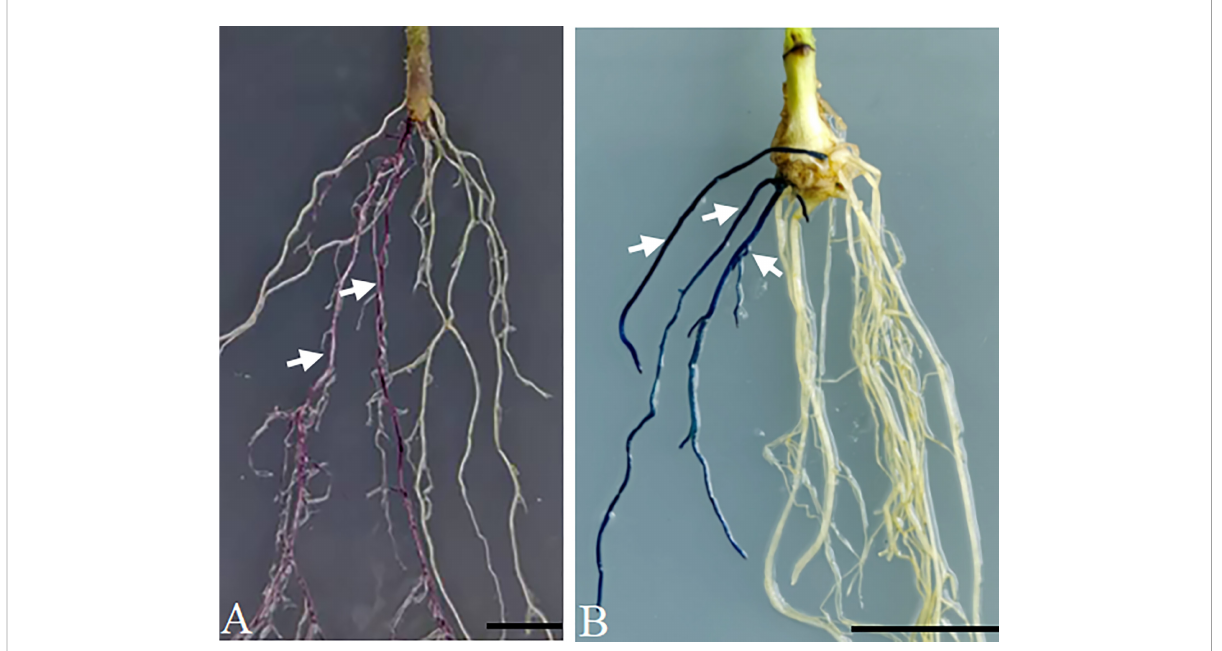
FIGURE 6 Veri fi cation of the overexpression vector p-35BTR1/2 in plants. Anthocyanin accumulated in the transgenic hairy roots of tomato transformed with pK35BTR1 -AtMyb75 (A) . The GUS signal was observed in the transgenic hairy roots of soybean transformed with pK35BTR2 -GUSPlus (B) . Arrows indicate the transgenic roots; bars=1